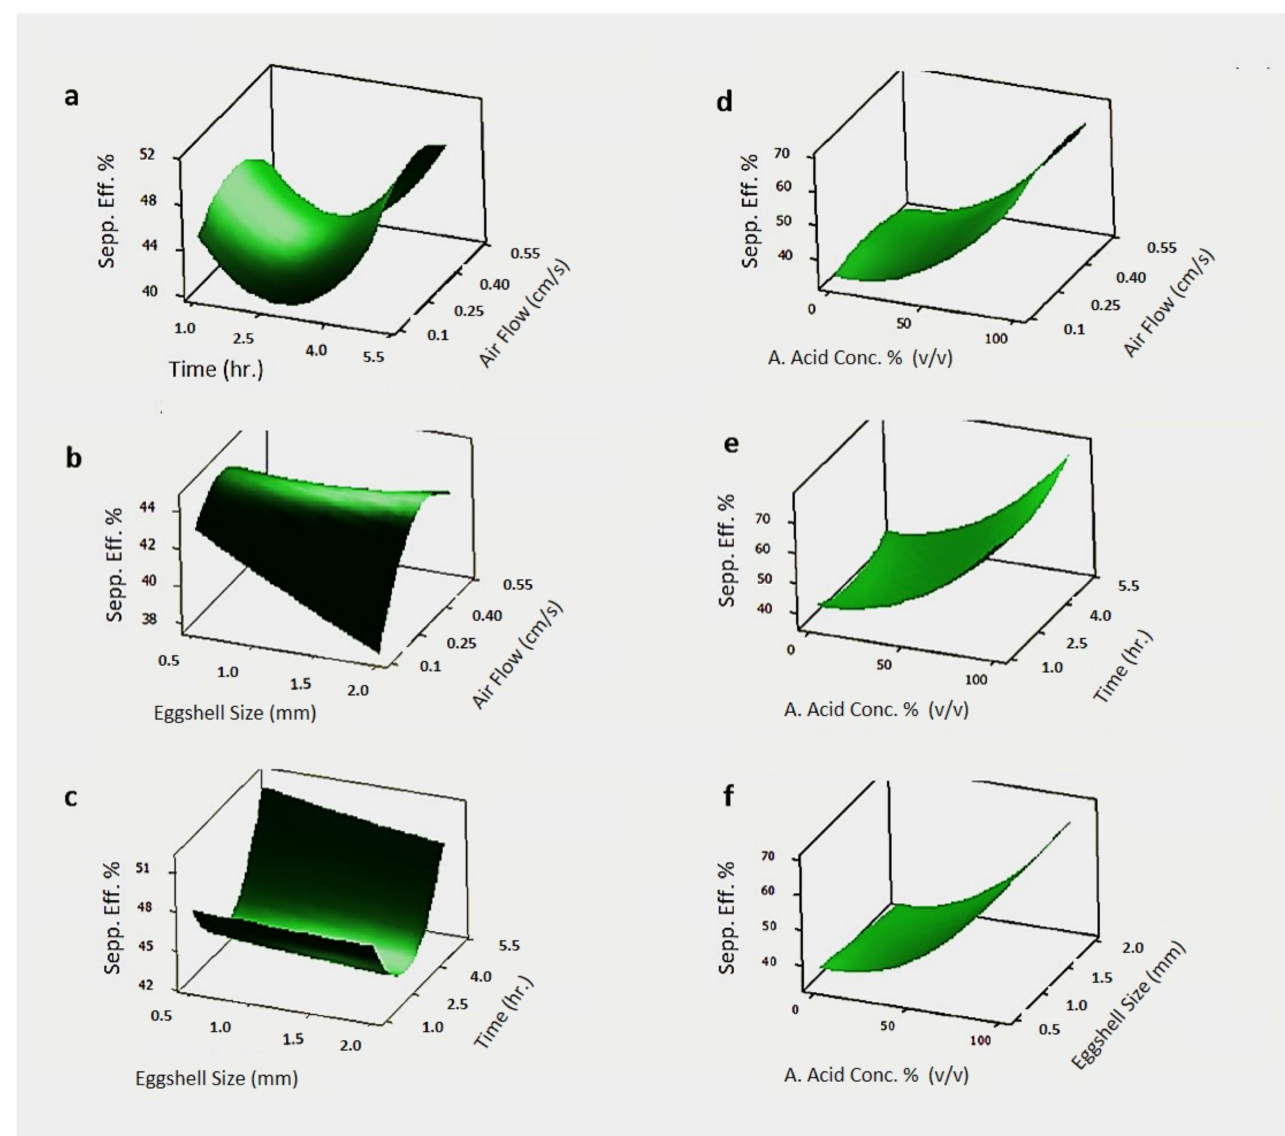
Figure 6. Response surface graphs of the separation efficiency (%) with acetic acid concentration 50%; ( a ) treatment time vs air flowrate (average eggshell size is 1.25 mm); ( b ) eggshell size vs air flowrate (treatment time 3 h); ( c ) eggshell size vs treatment time (air flowrate 0.3 cm/s); ( d ) acetic acid concentration vs air flowrate (average eggshell size 1.25 mm and treatment time 3 h); ( e ) acetic acid concentration vs treatment time (average eggshell size 1.25 mm and airflow rate 0.3 cm/h); ( f ) acetic acid concentration vs average eggshell size (treatment time 3 h and air flowrate 0.3